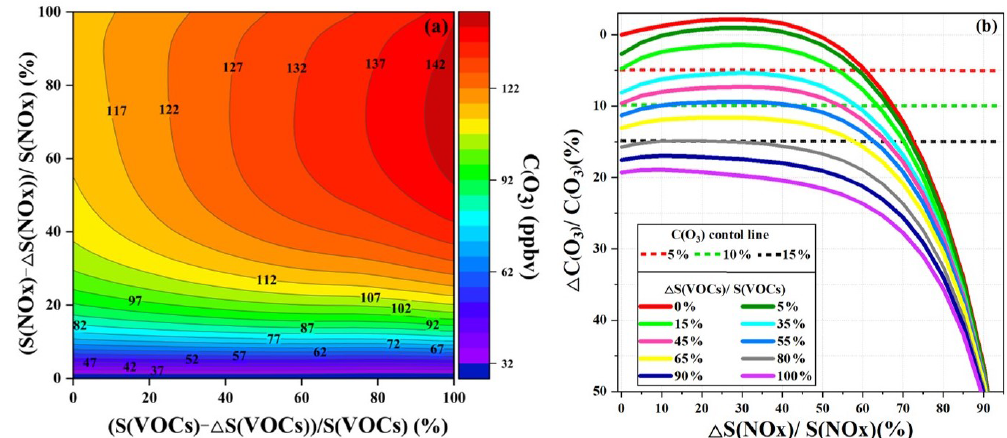
Figure 10. (a) Isopleth diagrams of modeled O 3 production potential (C(O 3 )) on S(VOC) and S(NO x ) remaining percent- ages (i.e., (S(VOCs) − (cid:49) S(VOCs)) / (S(VOCs)) and (S(NO x ) − (cid:49) S(NO x )) / (S(NO x ))). (b) Relationship of C(O 3 ) increment percentage ( (cid:49) C(O 3 ) / C(O 3 )) with S(NO x ) and S(VOC) reduction percentages ( (cid:49) S(NO x ) / S(NO x ) and (cid:49) S(VOCs) / S(VOCs)). Note that C(O 3 ), S(NO x ), and S(NO x ) represent the concentrations of corresponding pollutants.